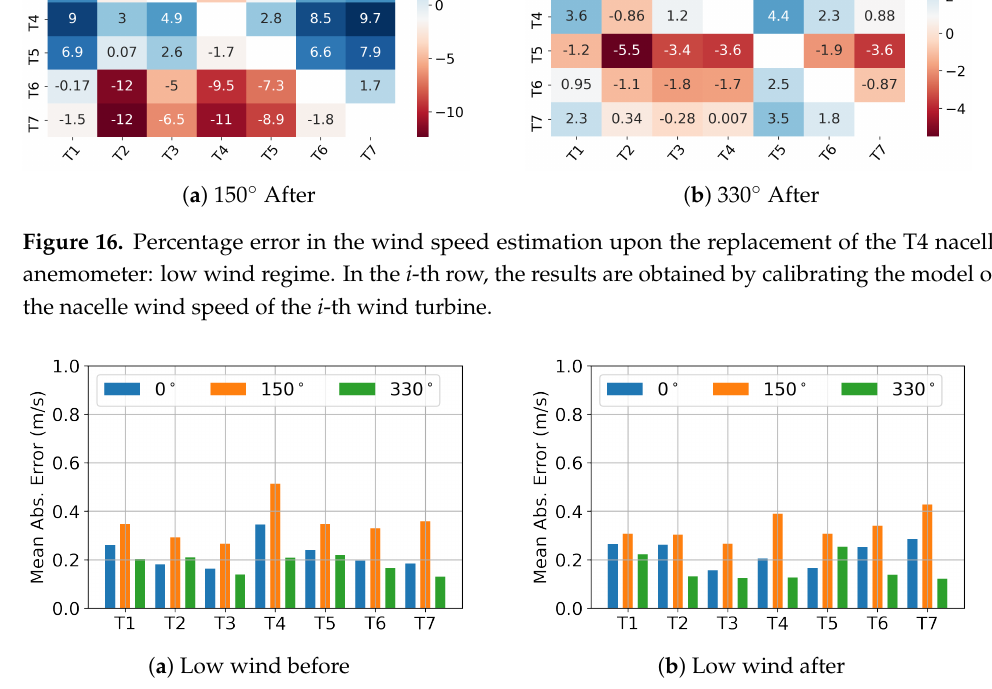
Figure 17. The mean absolute error between simulation and measurements for the sectors 0 ◦ , 150 ◦ and 330 ◦ , before and after the replacement of the T4 nacelle anemometer: low wind